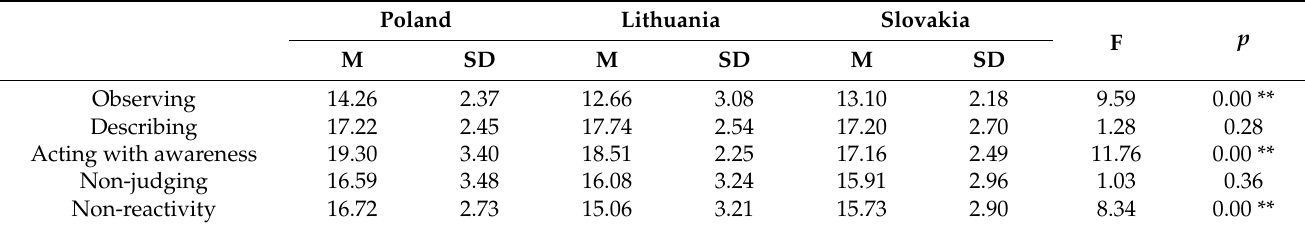
Table 2. Differences among drivers from Lithuania, Slovakia, and Poland in the mindfulness